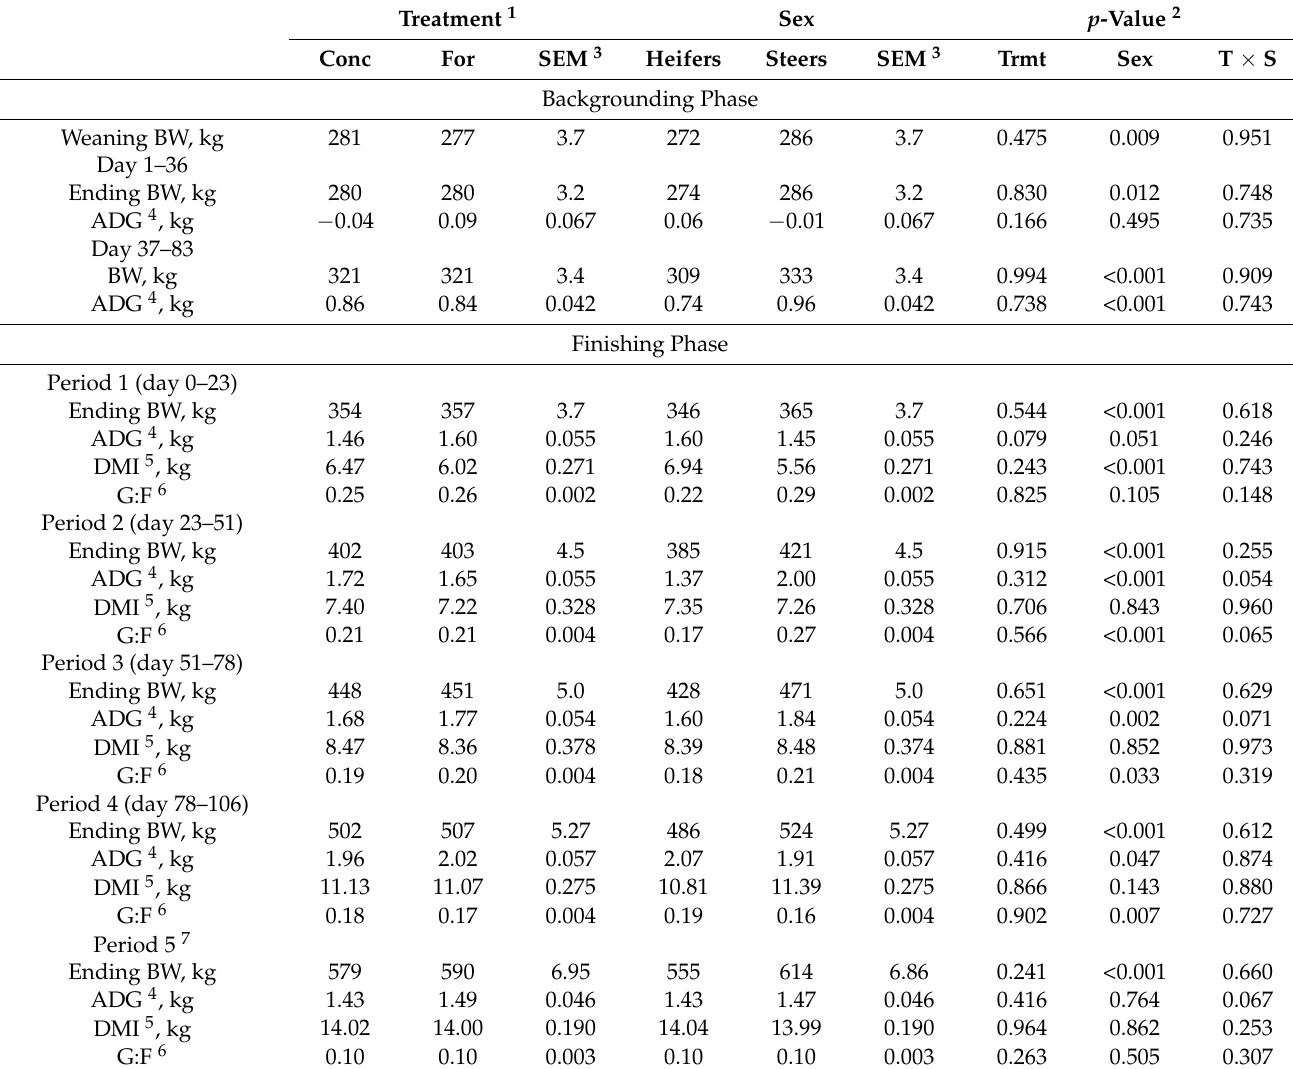
Table 3. Growth performance for progeny of dams fed a prepartum dietary carbohydrate source consisting of concentrate- based (Conc) or forage-based (For) diet during mid- and